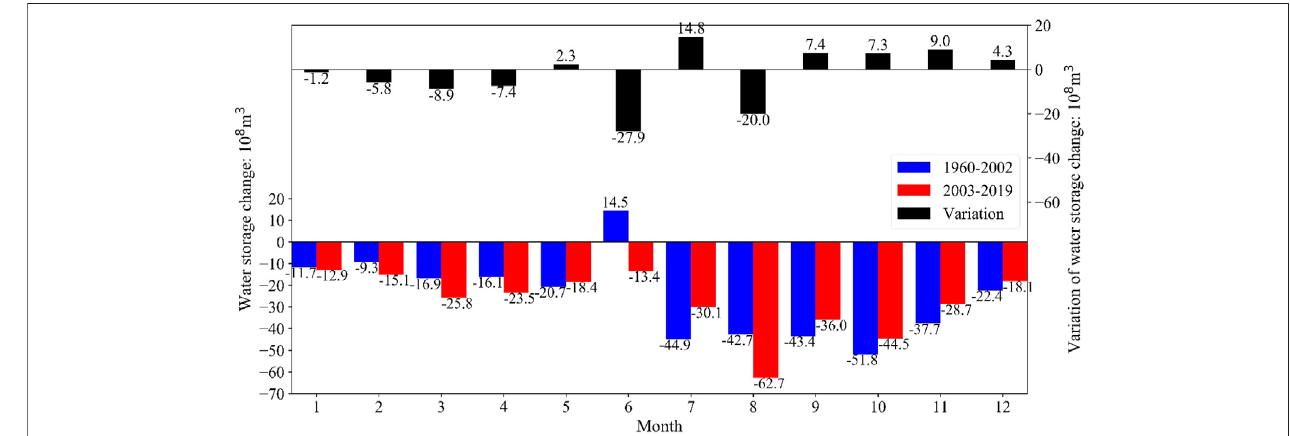
FIGURE 6 | Water storage changes of the Dongting Lake and variations at different periods of time.